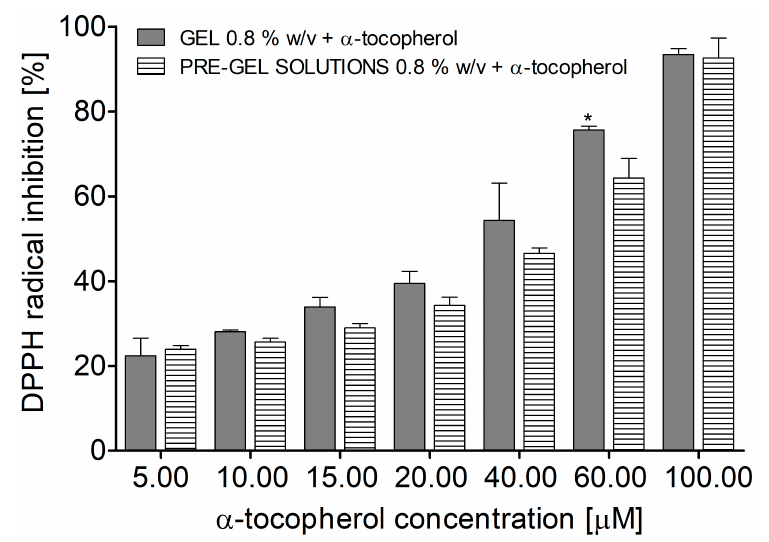
Figure 3. DPPH radical inhibition (%) by α -tocopherol in gels and in pre-gel solutions (0.8% w / v ) of Boc-L-DOPA(Bn) 2 -OH in DMSO:H 2 O (7:3 v / v ) (mean value ± SD, n = 3). The stars (*) above the columns indicate a statistically significant difference ( p < 0.05) between α -tocopherol in a specific concentration in gel vs. in pre-gel solution after breaking the gel.